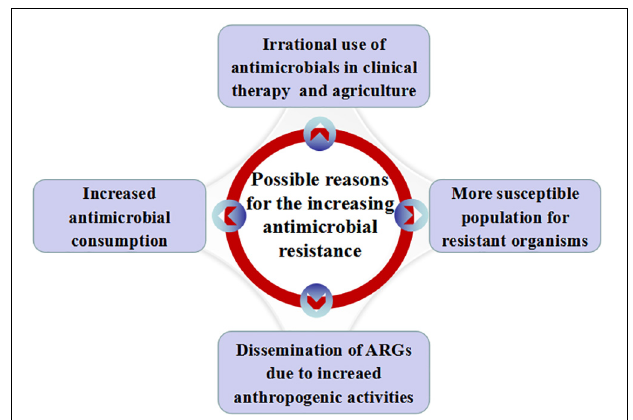
FIGURE 1 | Possible reasons for the increasing antimicrobial resistance in China. Possible reasons include increased antimicrobial consumption, irrational use of antimicrobials in clinical practice and agriculture, dissemination of ARGs with the increase of anthropogenic activities and more susceptible people for resistant